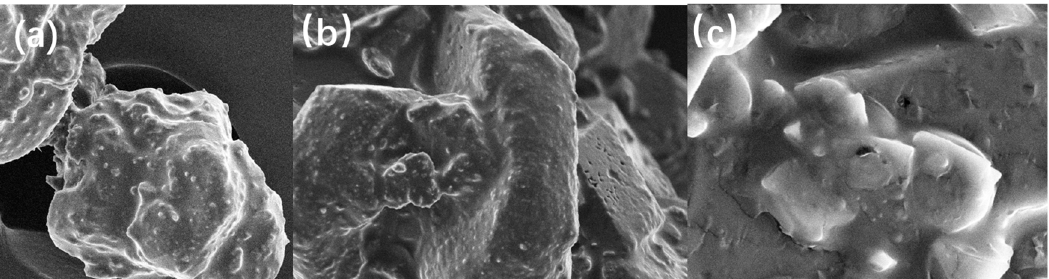
Figure 4. Electron microscopic morphology of coated grains: ( a ) 500 times; ( b ) 1000 times; ( c ) 5000 times.